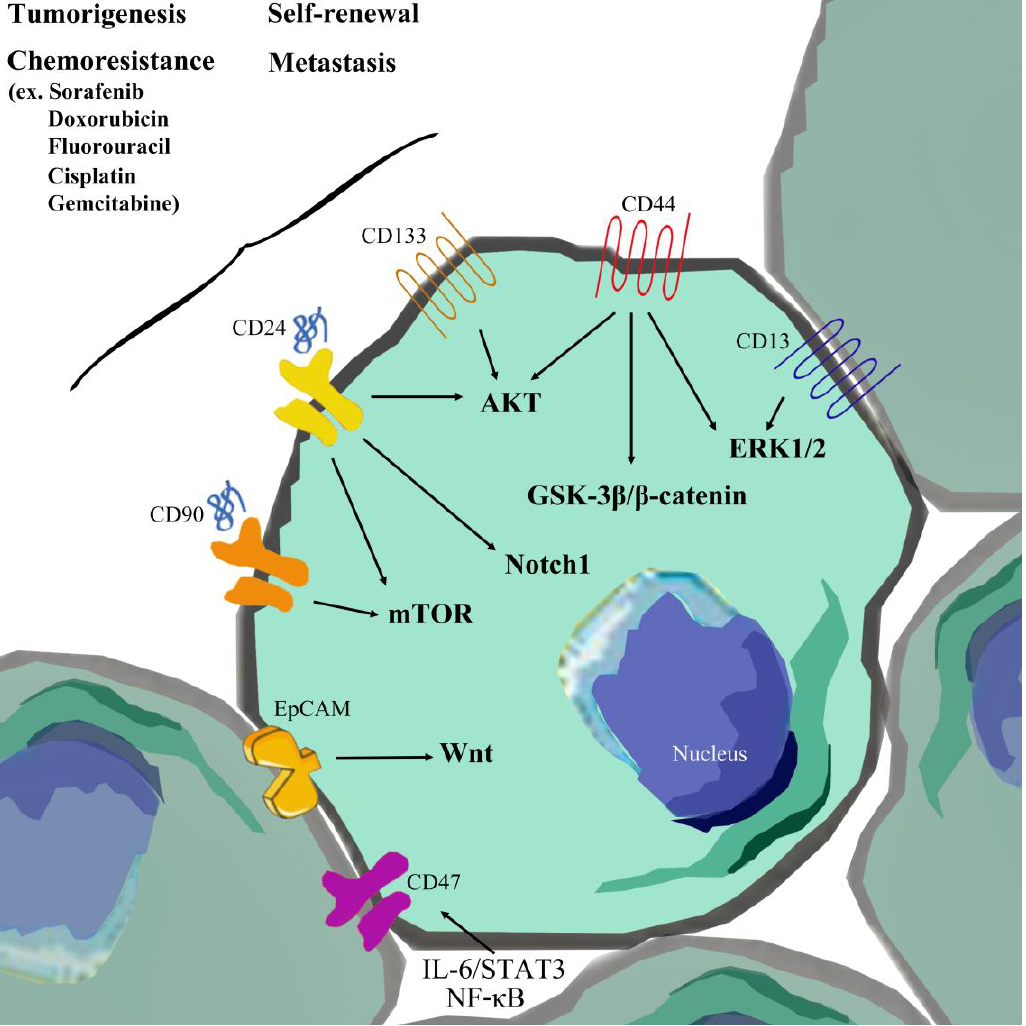
Figure 1. Activation of signaling pathways in liver cancer stem cells (LCSCs) influences hepatocellular carcinoma (HCC) development. Surface markers (including EpCAM, CD133, CD44, CD13, CD90, CD24, and CD47) influence the activation of signaling pathways, phenotypes, and resistance to clinical drugs in